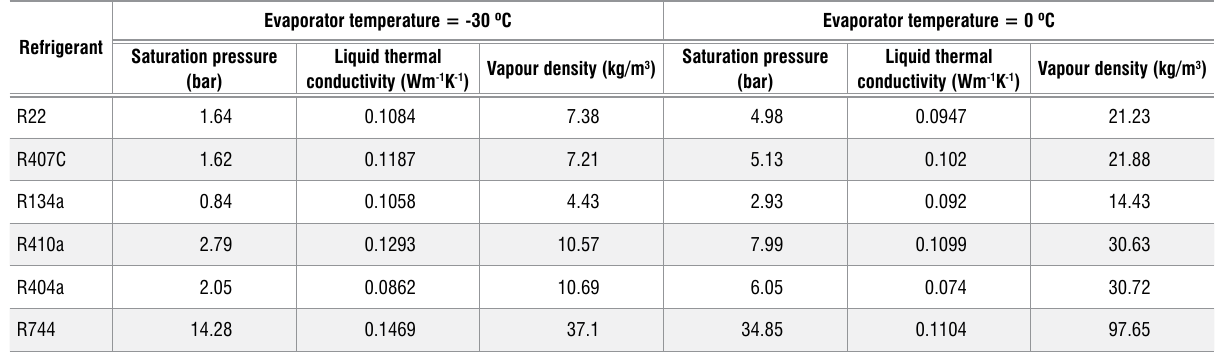
Properties of several common refrigerants 21